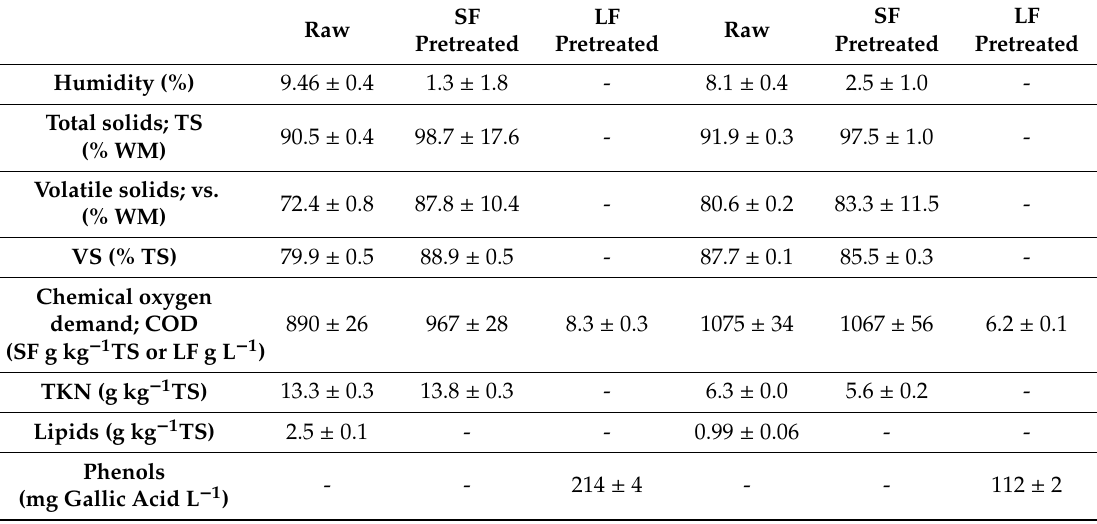
Table 1. Composition of the sunflower heads and stalks (raw) as well as their solid and liquid fractions (SF and LF respectively) after alkaline pretreatment.